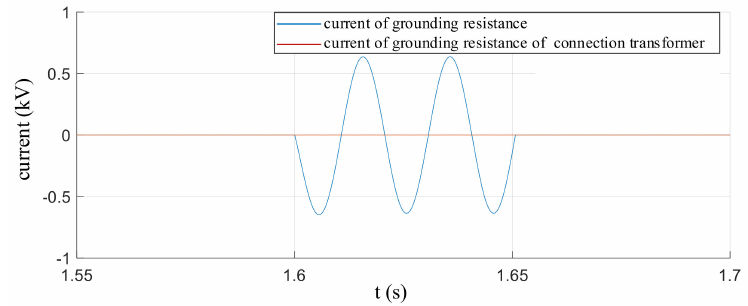
Figure 7. Current waveform flowing through the grounding resistance.